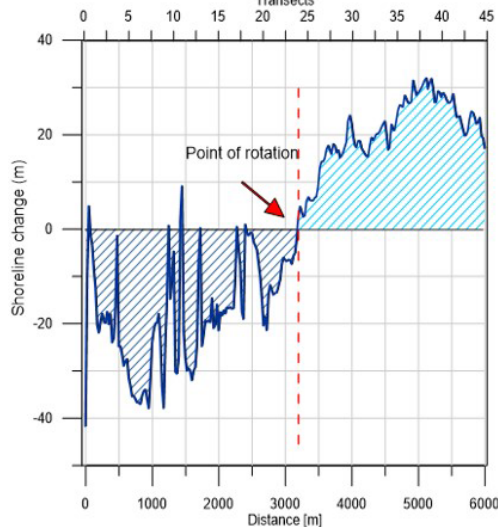
Figure 11. Shoreline change between 1992 and 2013 at Cell III. (Note that light area is accretion and dark area is